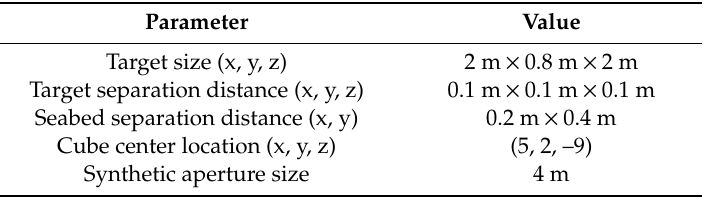
Table 3. Simulation parameters for target with shadows.